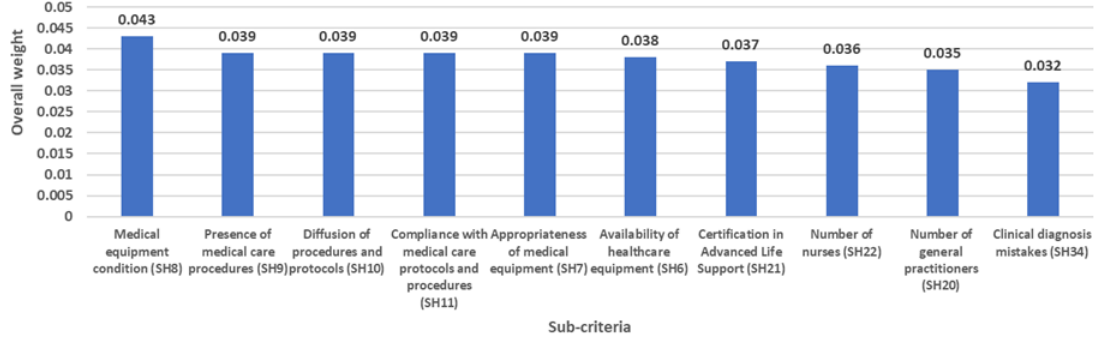
Figure 5. Ranking of sub-criteria in the ED performance evaluation model.